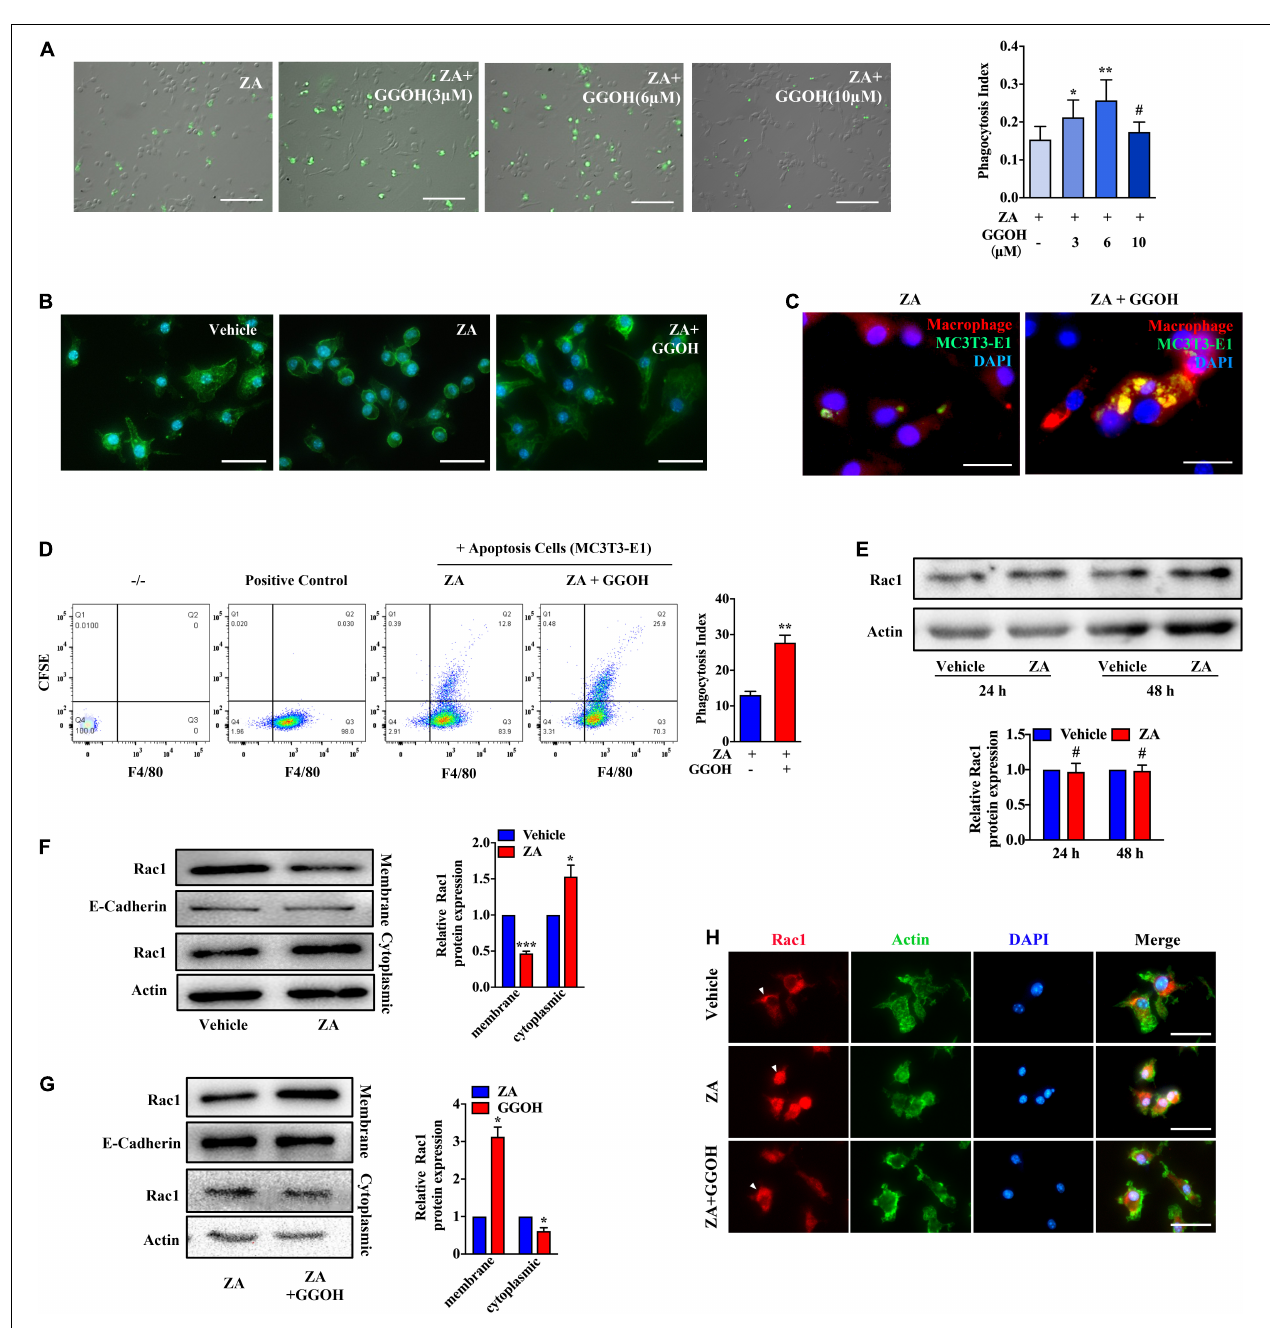
FIGURE 2 | GGOH restores ZA-induced inhibition of Rac1 membrane displacement and macrophage efferocytosis. (A) After treatment with ZA for 24 h, BMDMs were subjected to CFSE-labeled apoptotic H9 for 1 h. The comparison was performed with ZA group. Scale bar, 200 µ m. (B) Morphology of BMDMs treated with vehicle, ZA, and GGOH for 24 h. Scale bar, 100 µ m. (C) Representative images of BMDMs (F4/80, red) ingested apoptotic MC3T3-E1 (CFSE, green). Scale bar, 50 µ m. (D) Flow cytometry analysis of macrophage phagocytosis of CFSE-labeled apoptotic MC3T3-E1 cells. Representative plot shows cells double positive for CFSE and the macrophage marker F4/80 indicating efferocytosis. (E) BMDMs were treated with 10 µ M ZA or vehicle for 24 or 48 h. The total Rac1 expression was detected using Western blotting. (F) Cytoplasmic and membrane Rac1 were separated and detected in BMDMs following ZA treatment for 24 h. (G) The cytoplasmic and membrane Rac1 were detected in BMDMs treated with ZA or ZA + GGOH. (H) Representative fluorescence micrographs of BMDMs stained for Rac1, Actin, and nuclear marker with following treatments. Scale bar, 100 µ m. The data are presented as the mean ± SEM values (n = 3). * p < 0.05, ** p < 0.01, *** p < 0.001, # p > 0.05. GGOH, geranylgeraniol; ZA, zoledronic acid; BMDMs, bone marrow-derived macrophages; CFSE, carboxyfluorescein succinimidyl